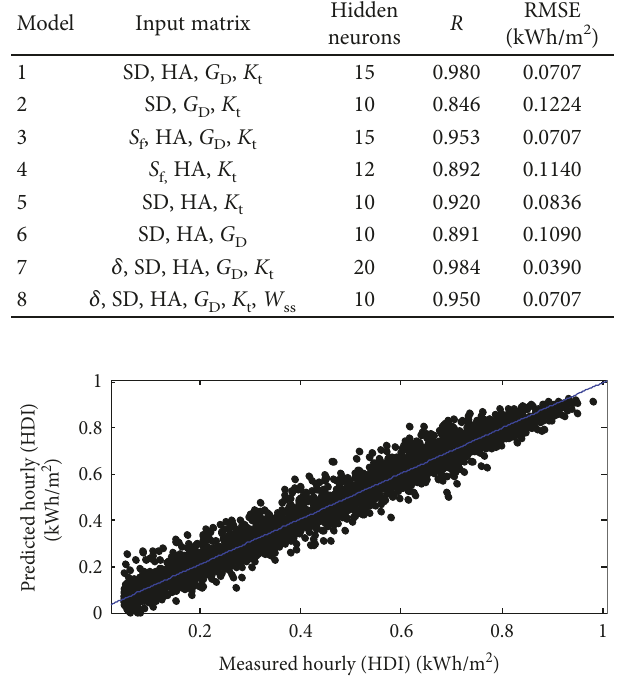
Figure 6: Predicted versus measured hourly HDI.